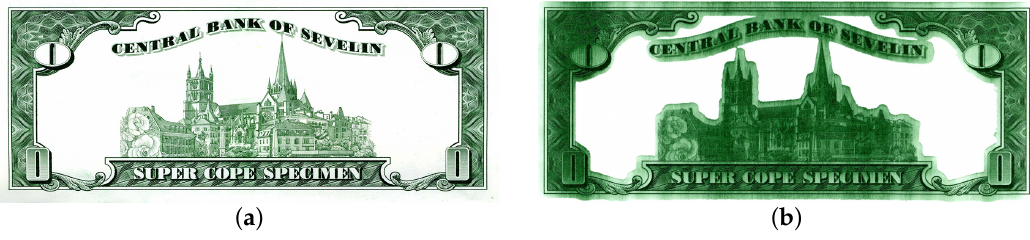
Figure 3. Effect of wiping errors in the intaglio printing process [92]. ( a ) Error-free intaglio print result; ( b ) Print errors caused by wiping errors.